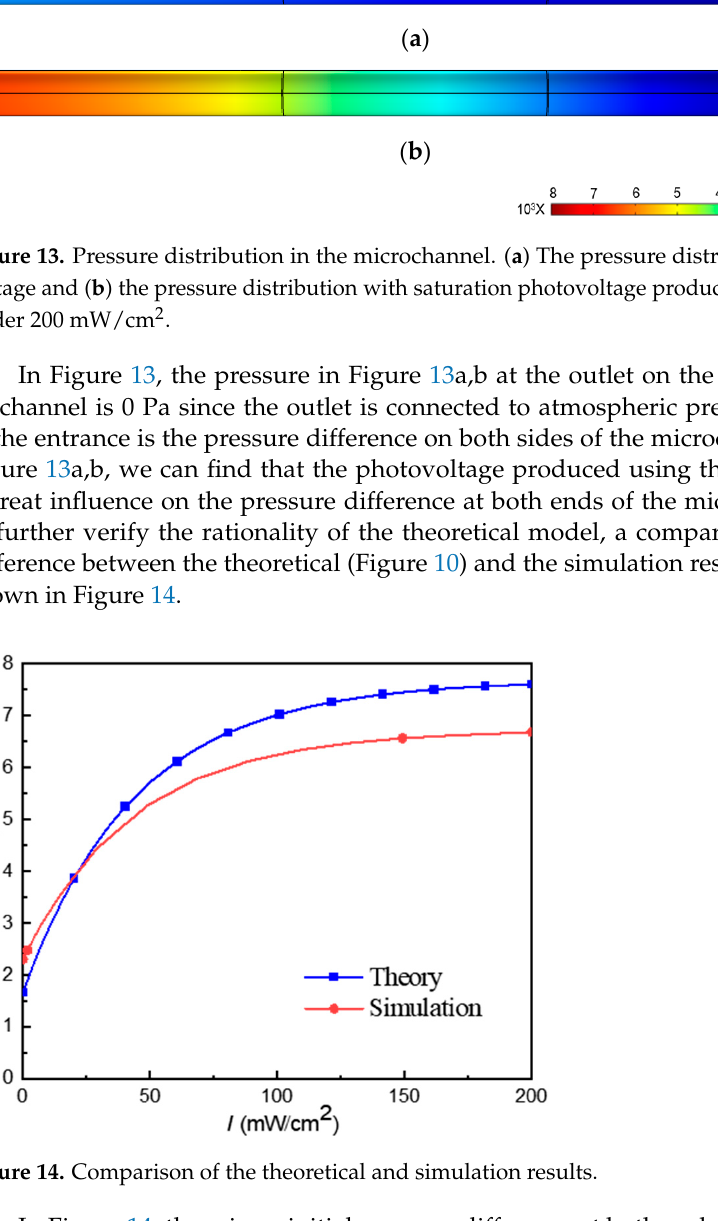
11 of 13 Figure 12. The flow velocity of the radial distribution.